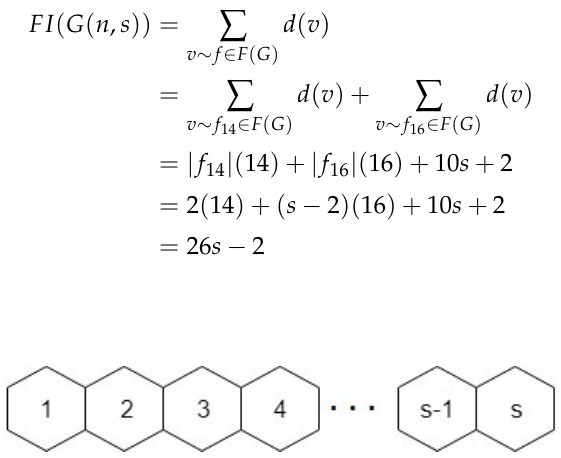
Figure 9. 2-dimensional structure of graphene with one row having s benzene